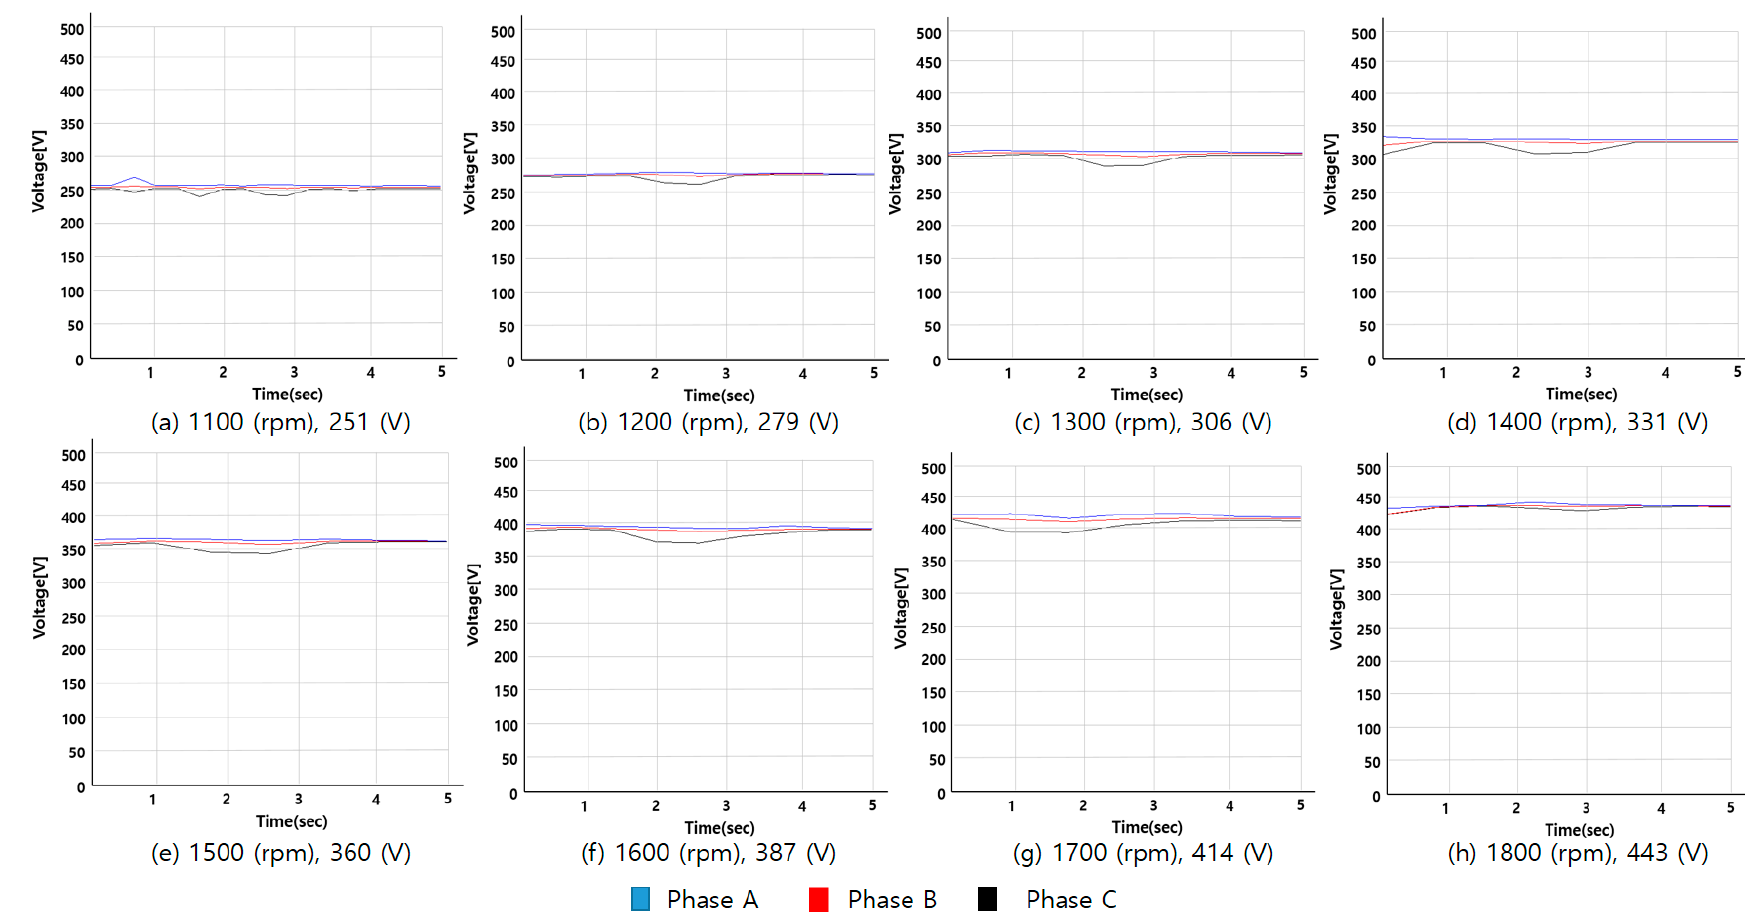
Figure 16. Output results of the reference voltage with respect to the generator speed.( a ) output voltage at 1100 rpm, ( b ) output voltage at 1200 rpm, ( c ) output voltage at 1300 rpm, ( d ) output voltage at 1400 rpm, ( e ) output voltage at 1500 rpm, ( f ) output voltage at 1600 rpm, ( g ) output voltage at 1700 rpm, and ( h ) output voltage at 1800 rpm.